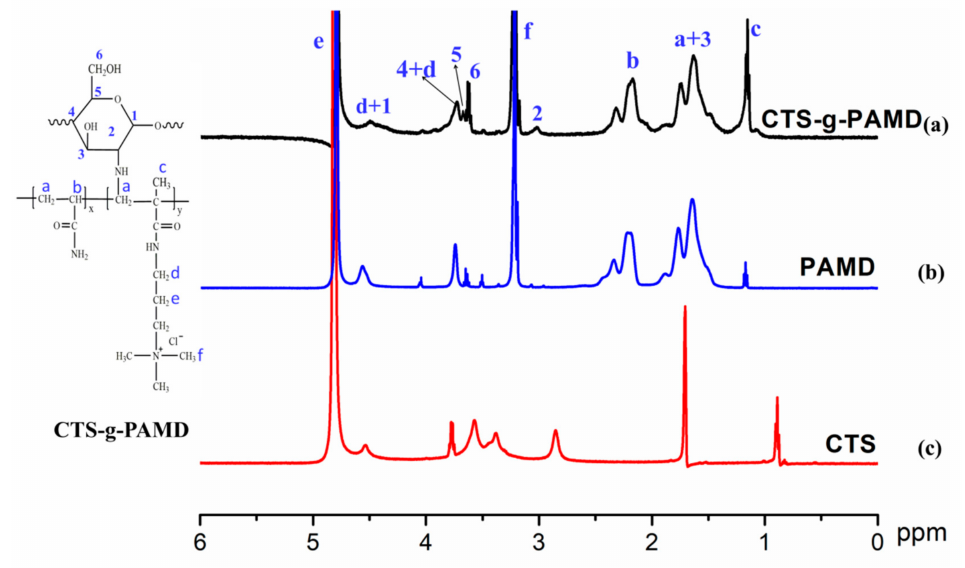
Figure 4. The 1 H NMR of the